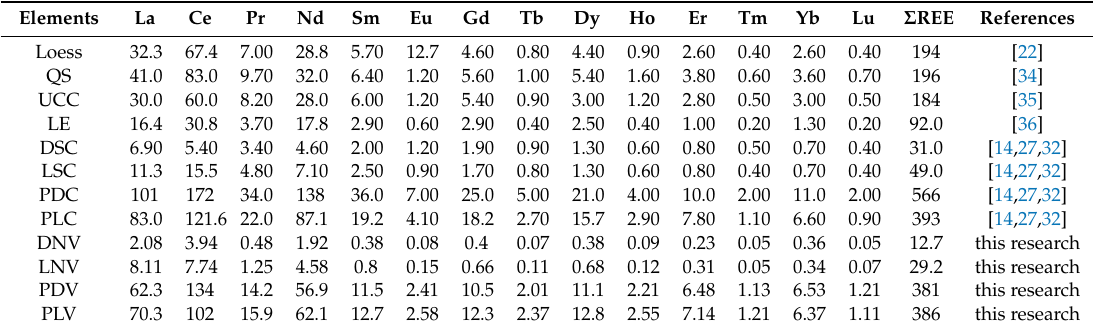
Table 3. Comparison of REE concentration (ppm) in di ff erent rocks, sediments, and soils on the